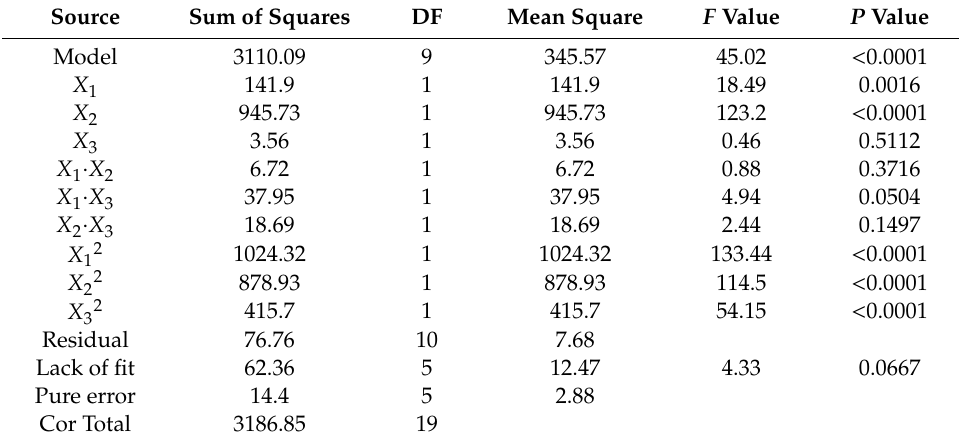
Table 3. The variance analysis of the fitting model.